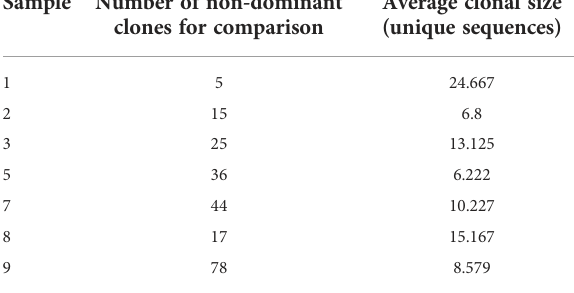
TABLE 4 Non-dominant clone numbers and average sizes. Sample Number of non-dominant clones for comparison